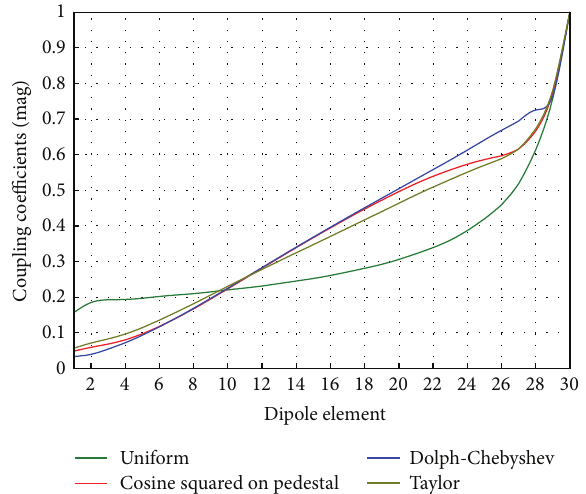
Figure 7: Coupling coefficients for different amplitude distributions in a series-fed linear dipole array; collinear configuration. 𝑑 = 0.1 𝜆 .